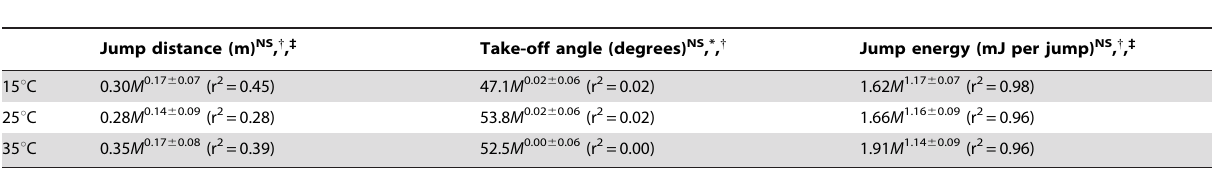
Table 2. Effect of temperature on allometric power equations for jump performance of juvenile Locusta migratoria .